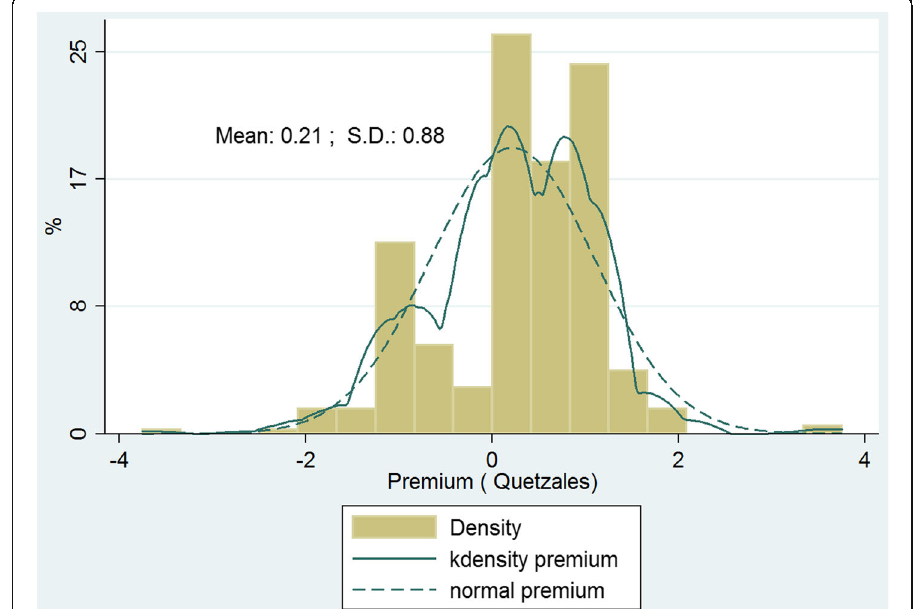
Fig. 2 Distribution of differences in WTP premium for 1 lb of the IB bean